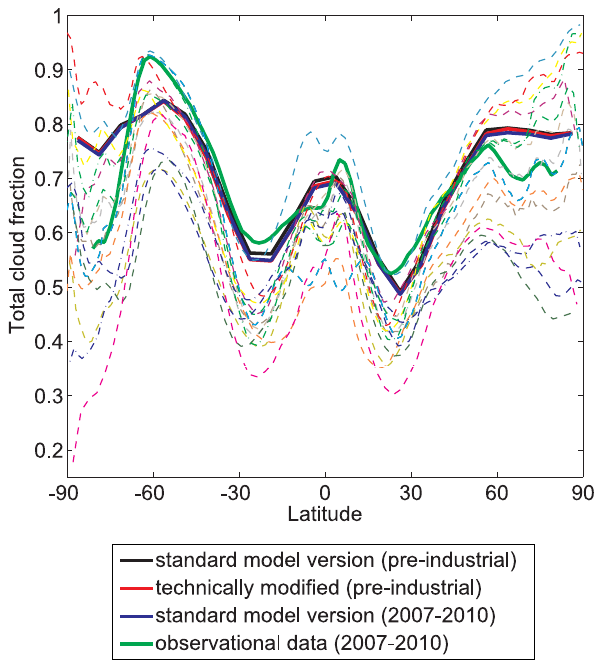
Fig. 1: Annual and zonal mean total cloud fraction. The solid lines show results from our model for the present-day (blue) and pre-industrial climate (standard model version in black, technically modified version as described in Sect. 2.4 given in red) as well as observational data (green, CALIPSO-GOCCP v2.1, Chepfer et al., 2010). For comparison, the dashed lines represent the results from simulations of the pre-industrial climate with different CMIP5 mod- els (Taylor et al.,